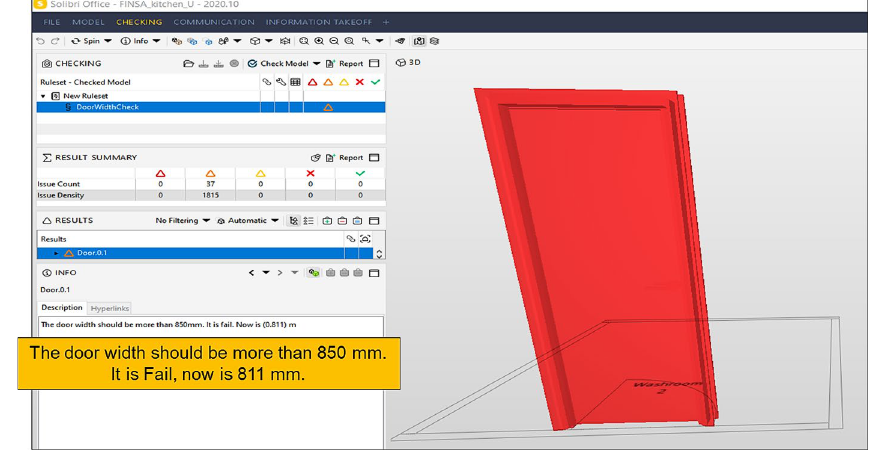
Figure 9. Result of “Door Width Check”